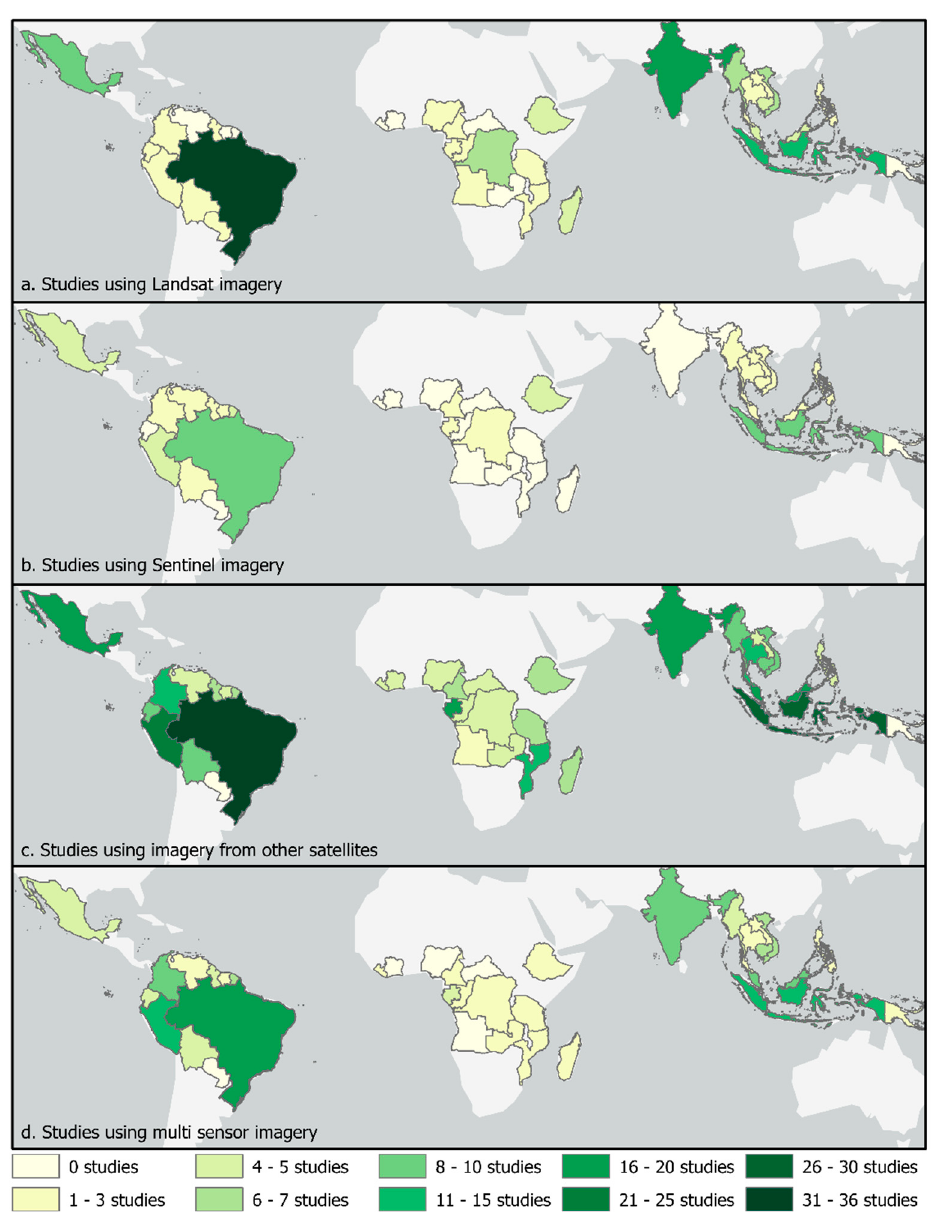
Figure 3. Classification of the countries regarding the usage level of Landsat imagery, Sentinel imagery, other satellites, and use of a multi-resolution approach.